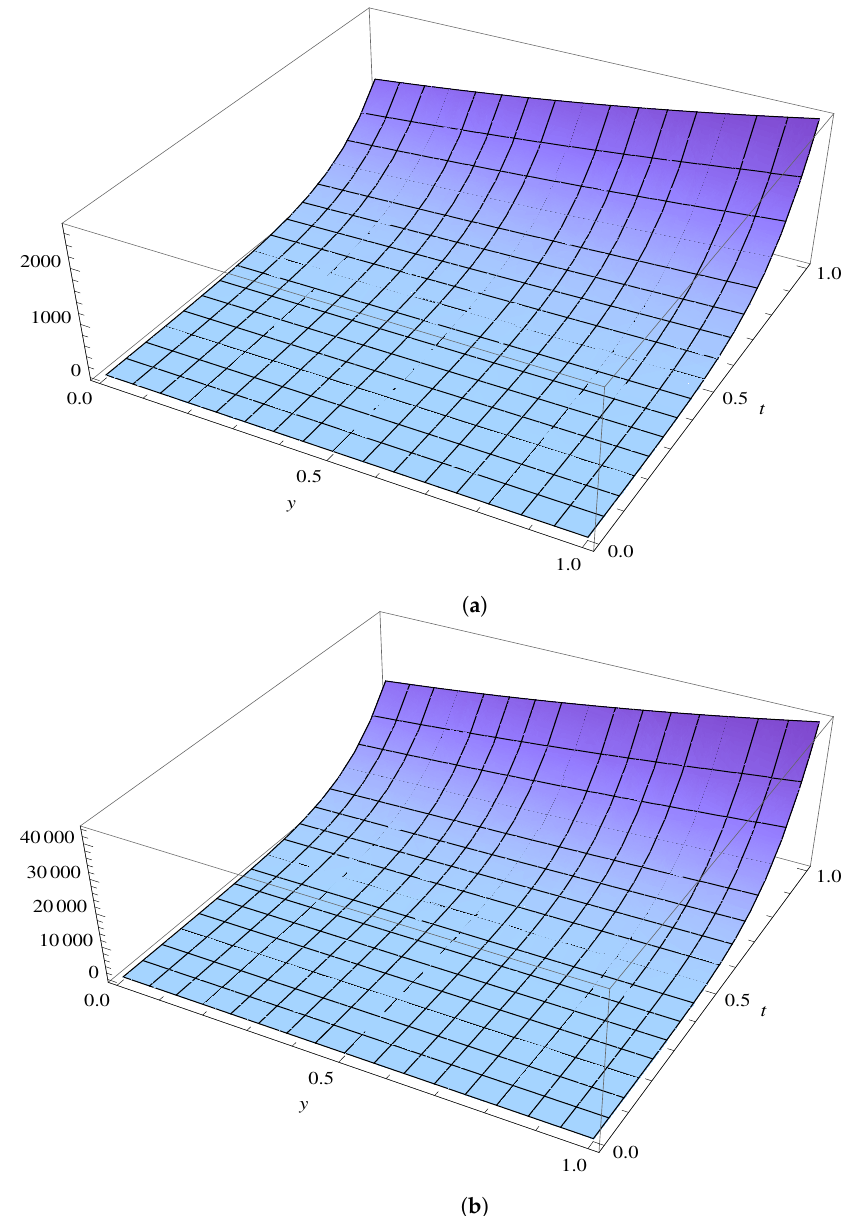
Figure 10. FRDTM solutions f ( x , y , z , t ) : ( a ) β = 0.9 and ( b ) β =